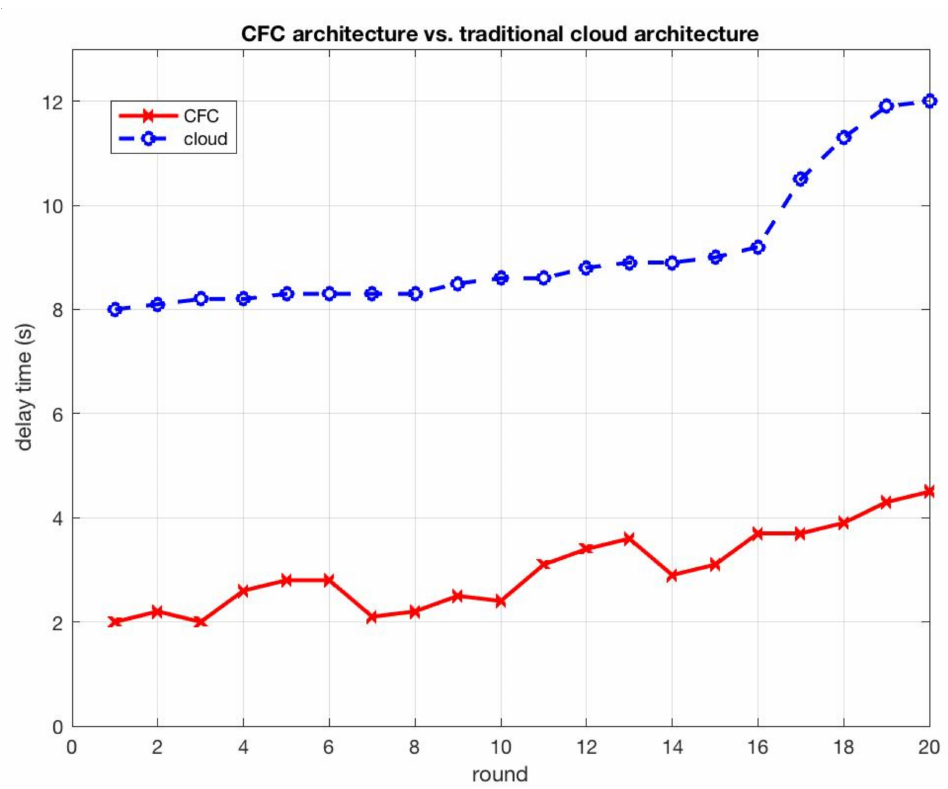
Figure 15. The response time of a query using the historical data (the proposed architecture vs. traditional